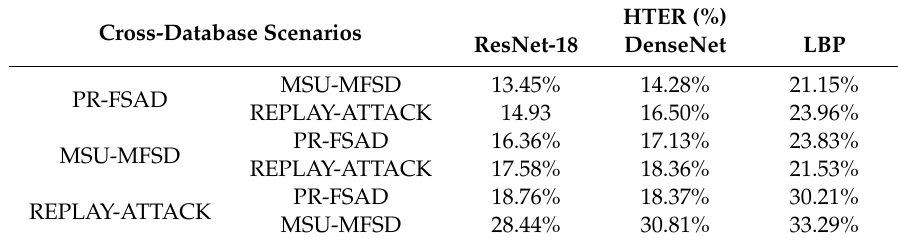
Table 6. Results of cross-database scenarios using ResNet-18, DenseNet, and LBP when using only frontal face images from the PR-FSAD (1st column: Trained DB, 2nd Column: Test DB).